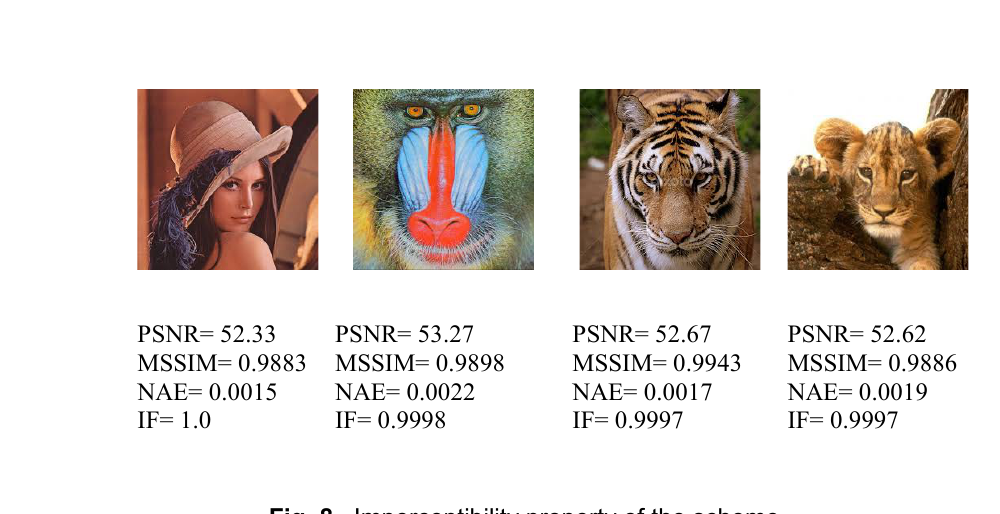
Fig. 8. Imperceptibility property of the